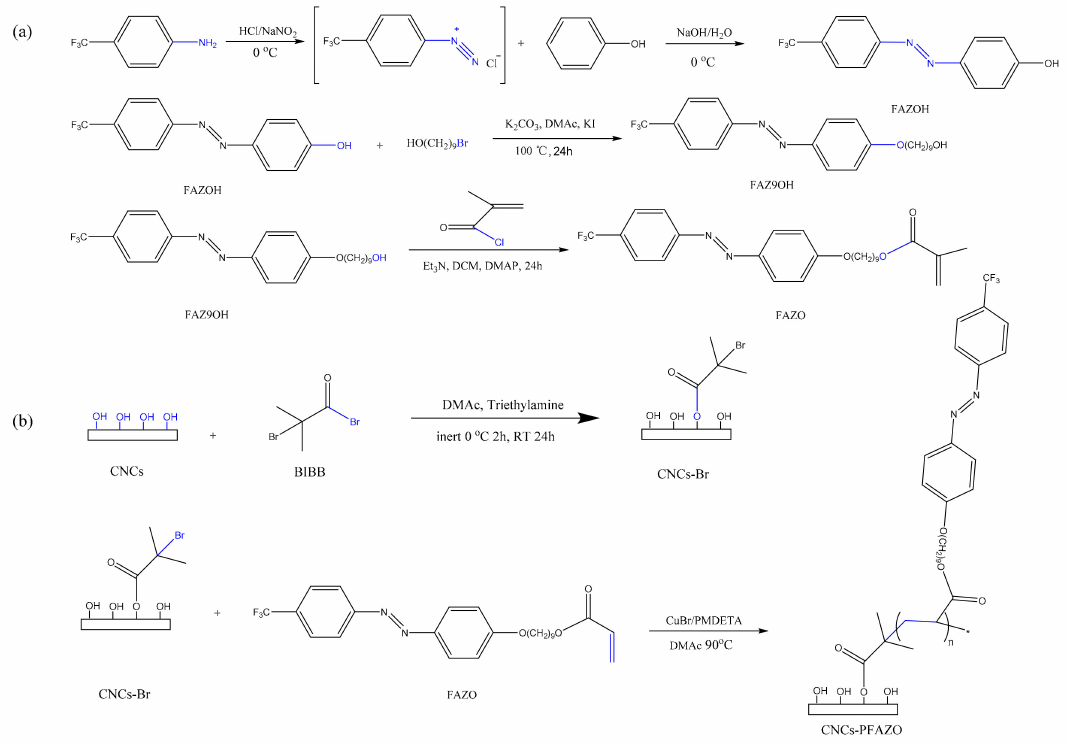
Figure 1. Synthesis of ( a ) 9-[4-[2-[4-(trifluorometh) phenyl] diazenyl] phenoxy] nonayl acrylate (FAZO)-monomers and ( b ) poly-FAZO brushes on cellulose